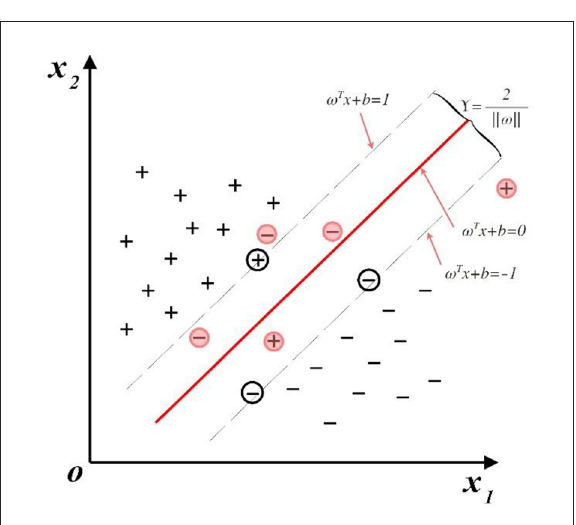
FIGURE2 Support vector and optimal hyperplane with slack